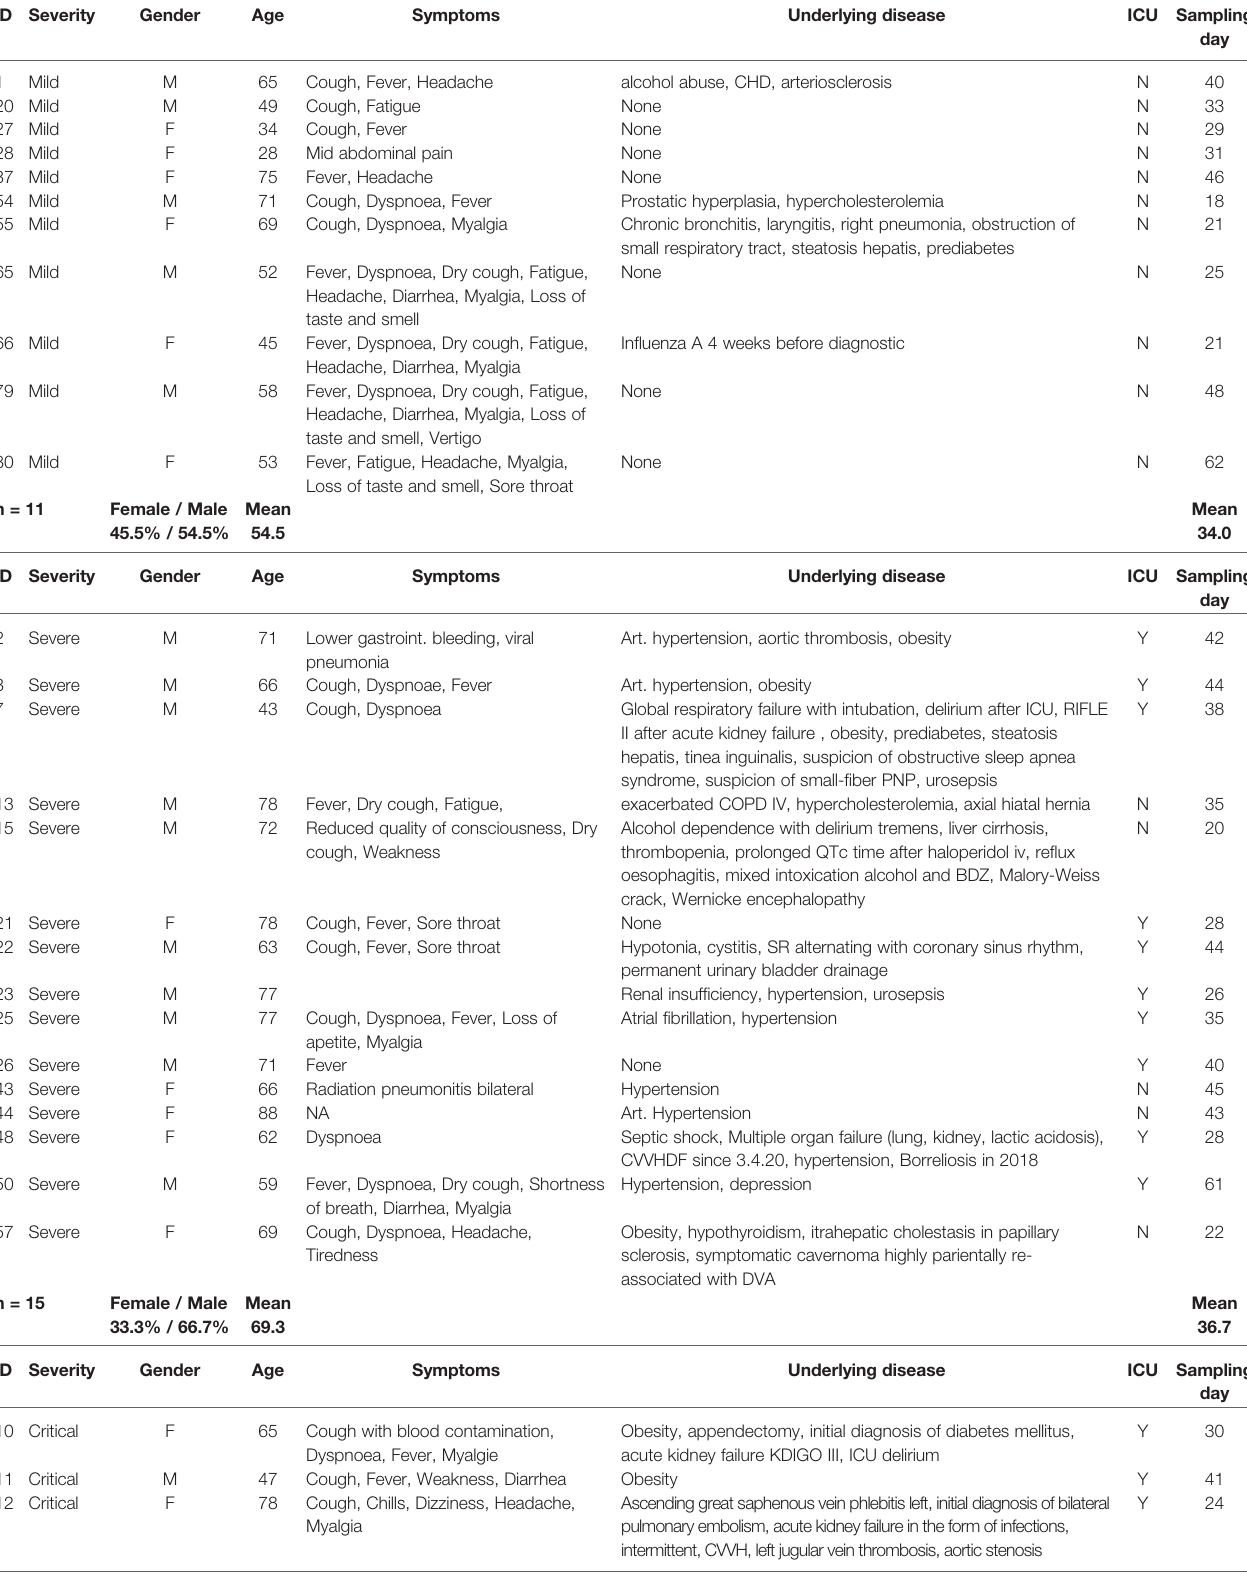
TABLE 1 | Characteristics from patients included in the study by COVID-19 severity (mild, severe, critical). ID Severity Gender